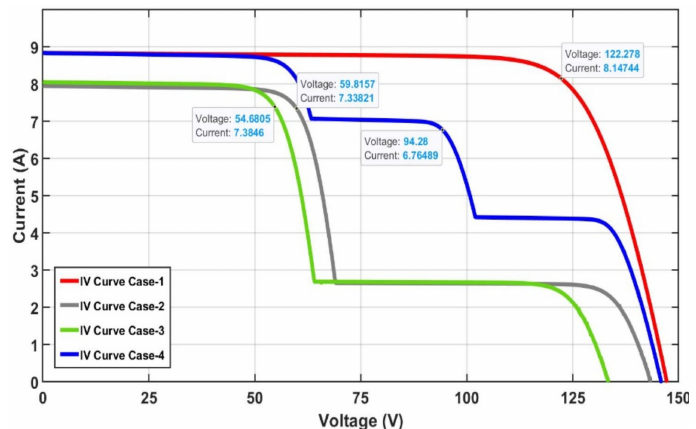
Figure 18. I-V characteristics of Array (All